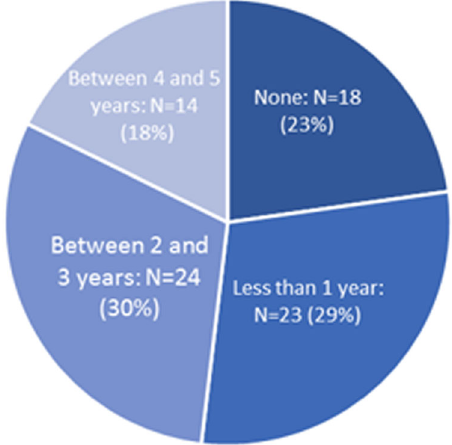
Fig. 5 Length of participation in IMAGE. Chart illustrating the distribution of participant ’ s involvement